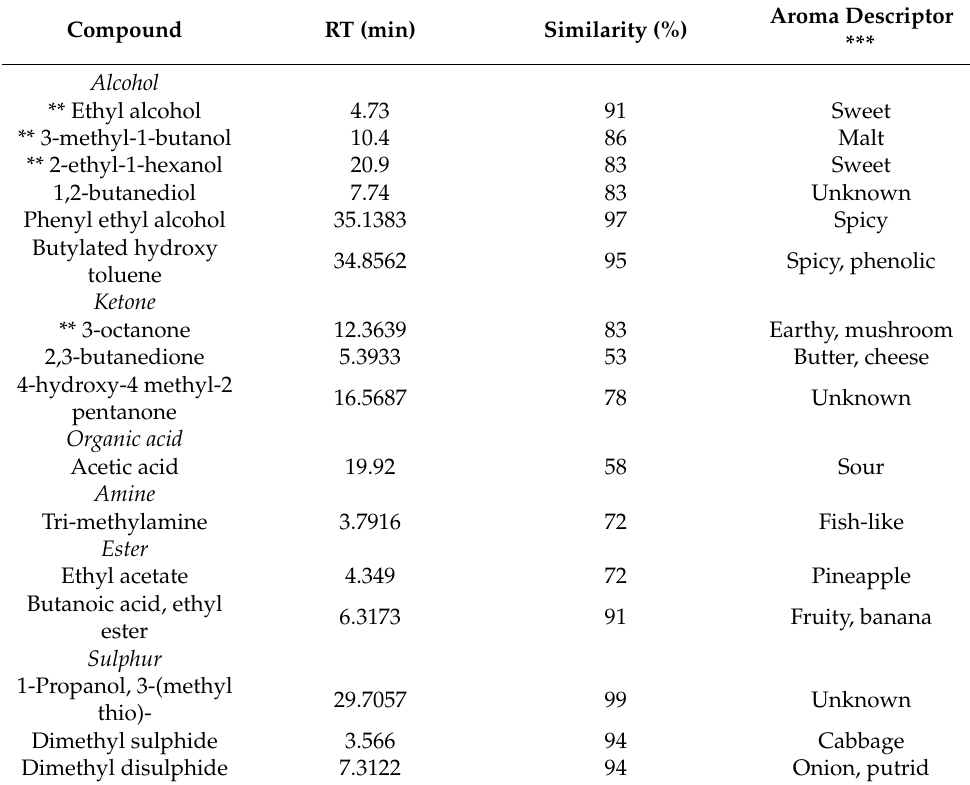
Table 2. Volatile compounds identified from MA-packaged Cape hake